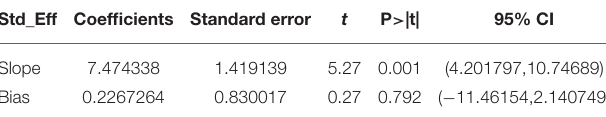
TABLE 5 | Results of publication